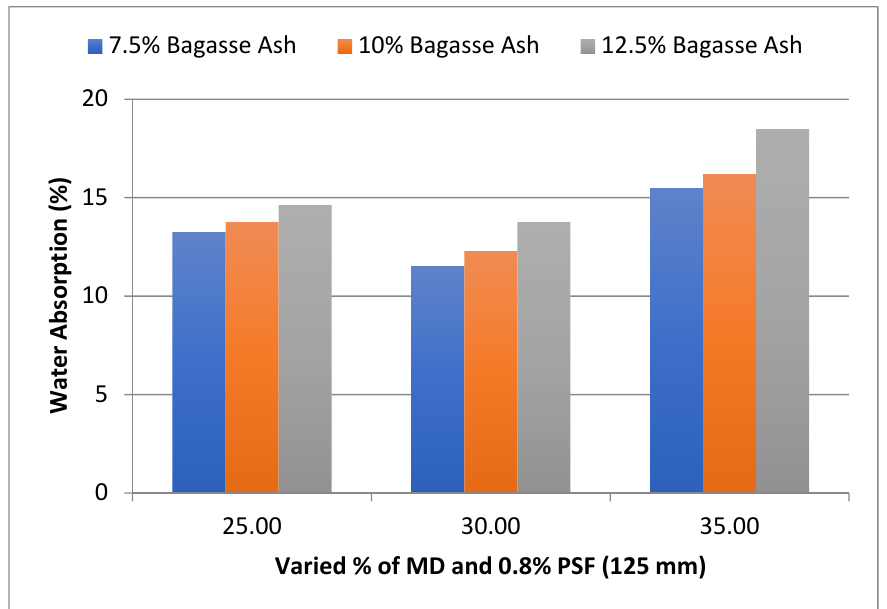
Figure 8. Effect of MD and BA on water absorption of block reinforced with 0.8% PS fiber (125 mm).